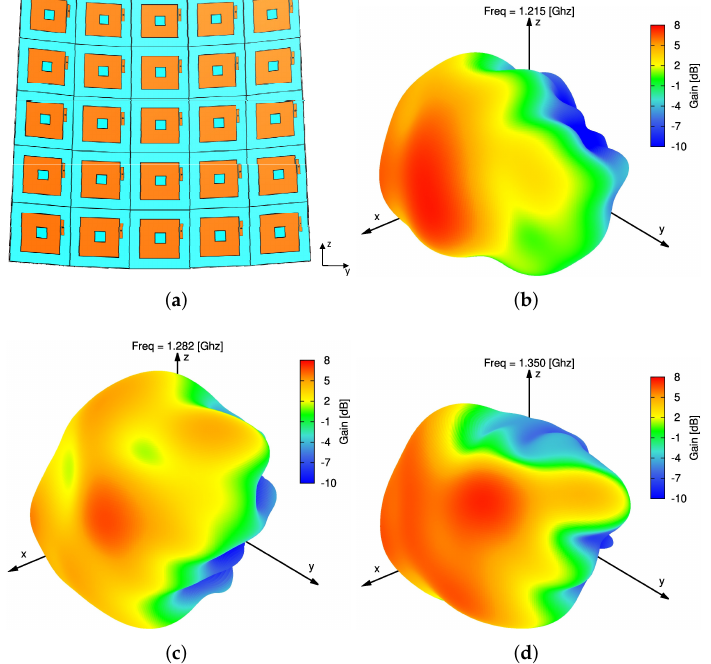
Figure 13. Numerical Assessment (Sparse CPA, M = 16, d = λ Plot of the power pattern in the ( v , w )-plane of the ( a ) b = 1, ( b ) b = 3, ( c ) b = 5, and ( d ) b = 7 beams when applying a Taylor tapering with SLL = − 30 dB and ¯ n = 4 to the excitations of the N c = 17 planks in the azimuth plane.